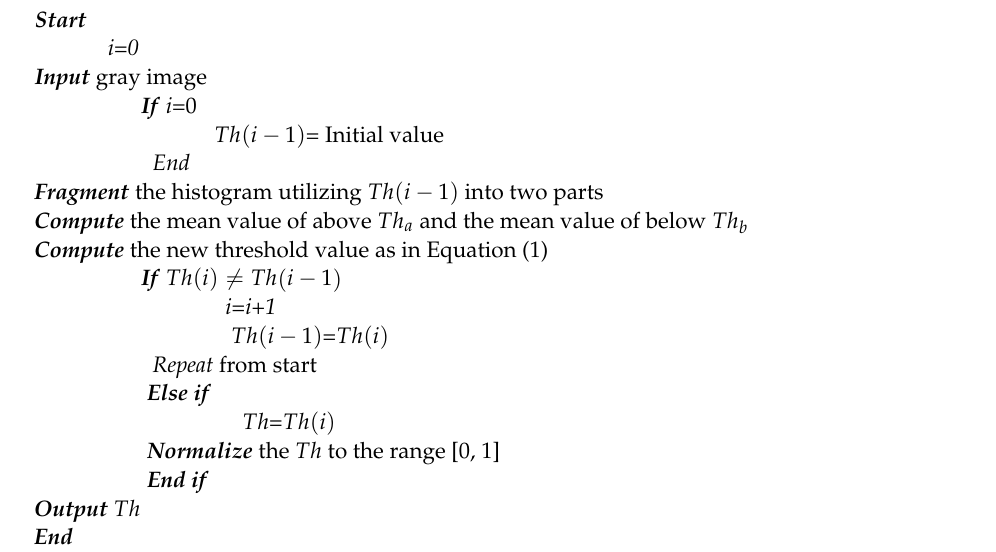
Algorithm 1. Thresholding